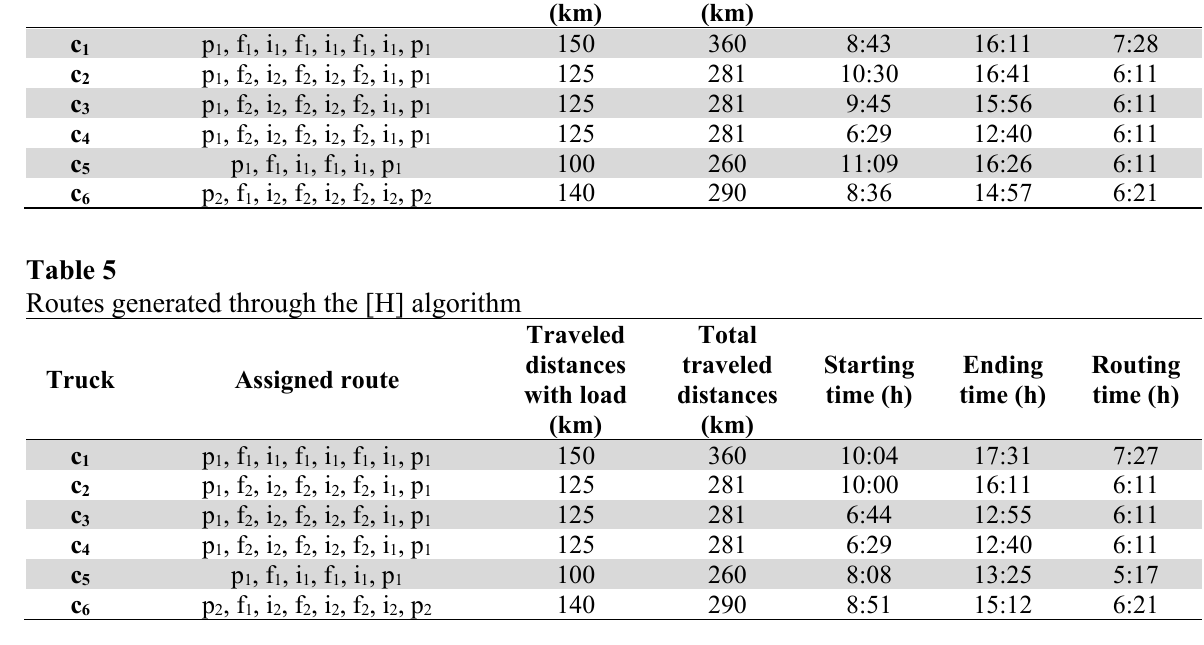
Table 4 Routes generated through the [FullP] model Truck Assigned route